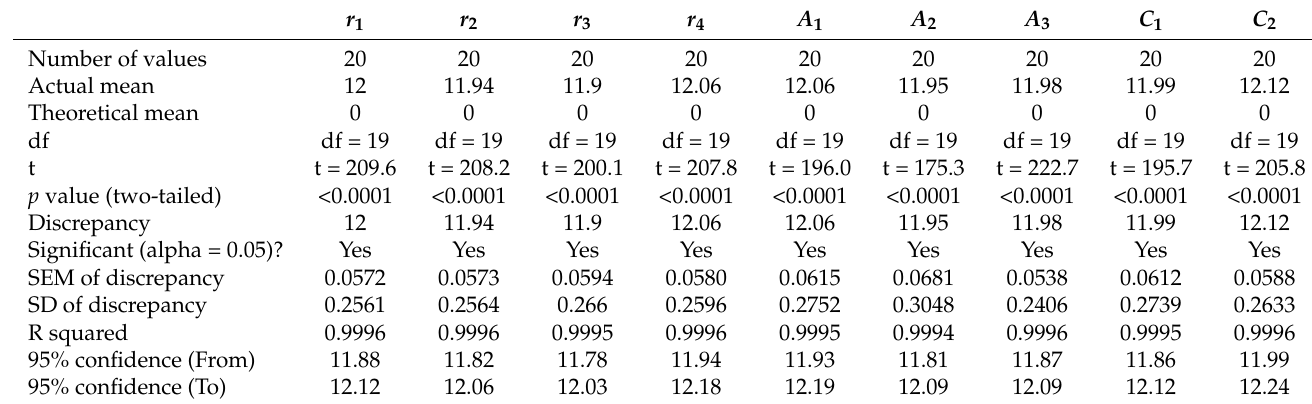
Table 18. Wilcoxon signed-rank test of the convergence time.